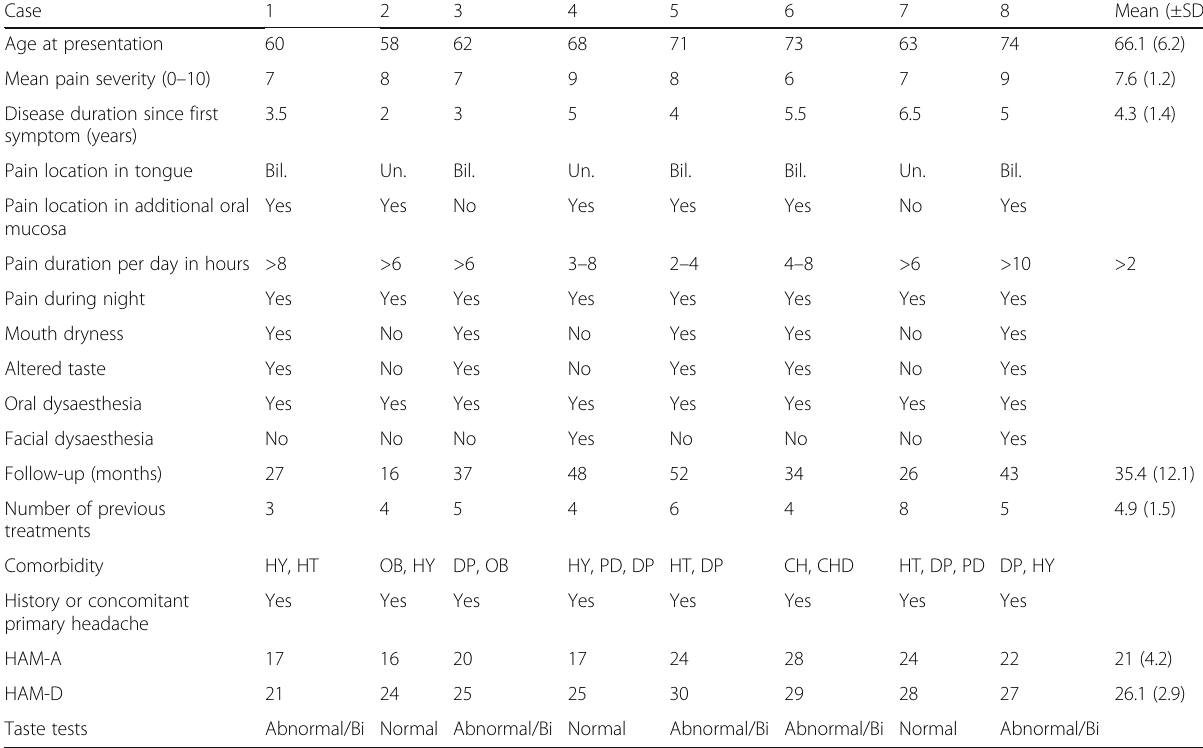
Table 1 Clinical characteristics of patients Case